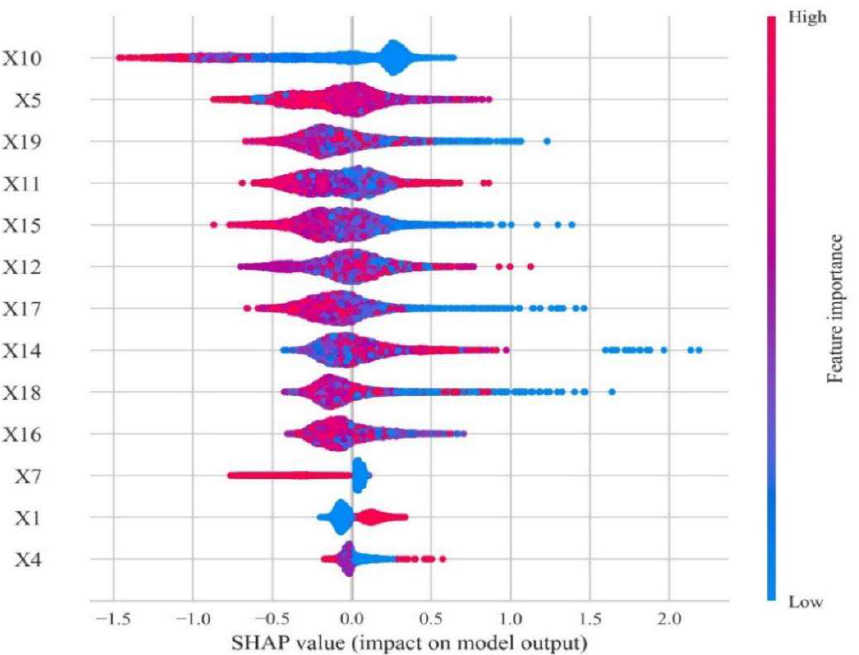
Figure 6. SHAP summary diagram of difficult students.